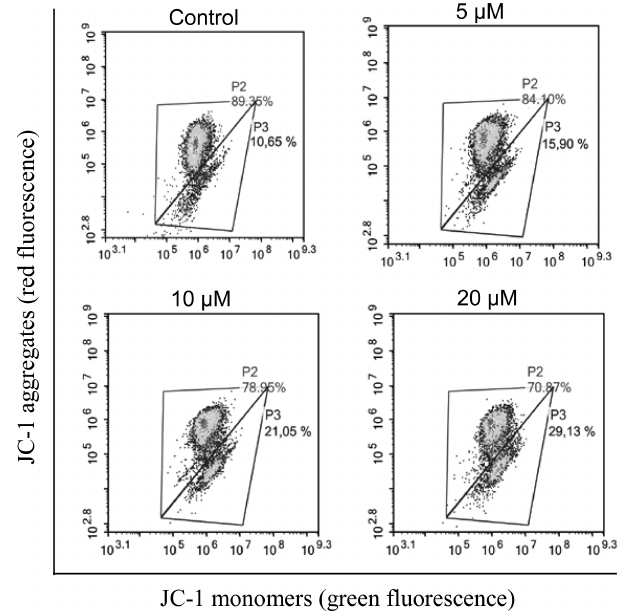
Figure 2. Analysis of mitochondrial transmembrane potential of KB-3-1 cells treated with the compound 3i by flow cytometry after JC-1 staining. Cells were incubated with 3i (5, 10 or 20 µM) or DMSO (0.1% v / v ) for 48 h. In normal cells, the dye is aggregated in mitochondria, and fluoresces red. In cells with altered mitochondrial potential, the dye fails to accumulate in the mitochondria, remained as monomers in the cytoplasm, and fluoresces green.